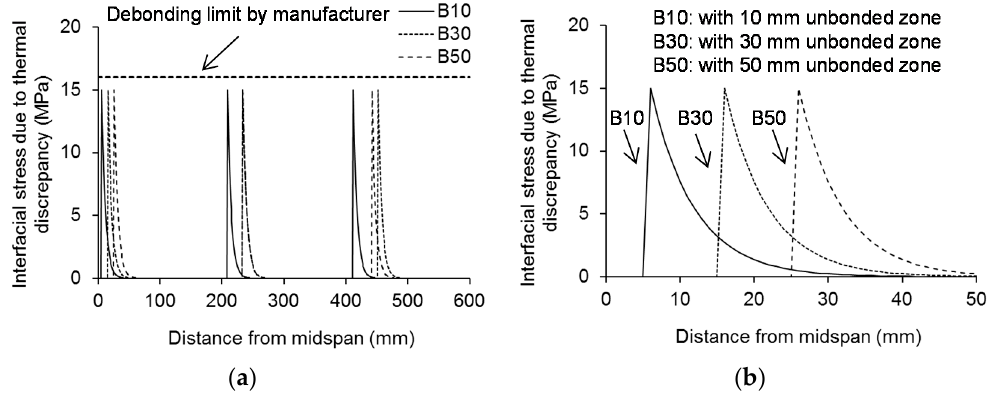
Figure 11. Predicted interfacial shear stress due to thermal loading of Δ T = 25 °C: ( a ) from midspan to support; ( b ) near midspan.